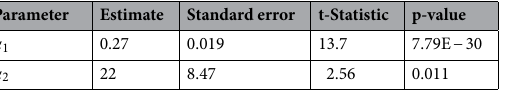
Table 2. Parameter table for ECSCT.